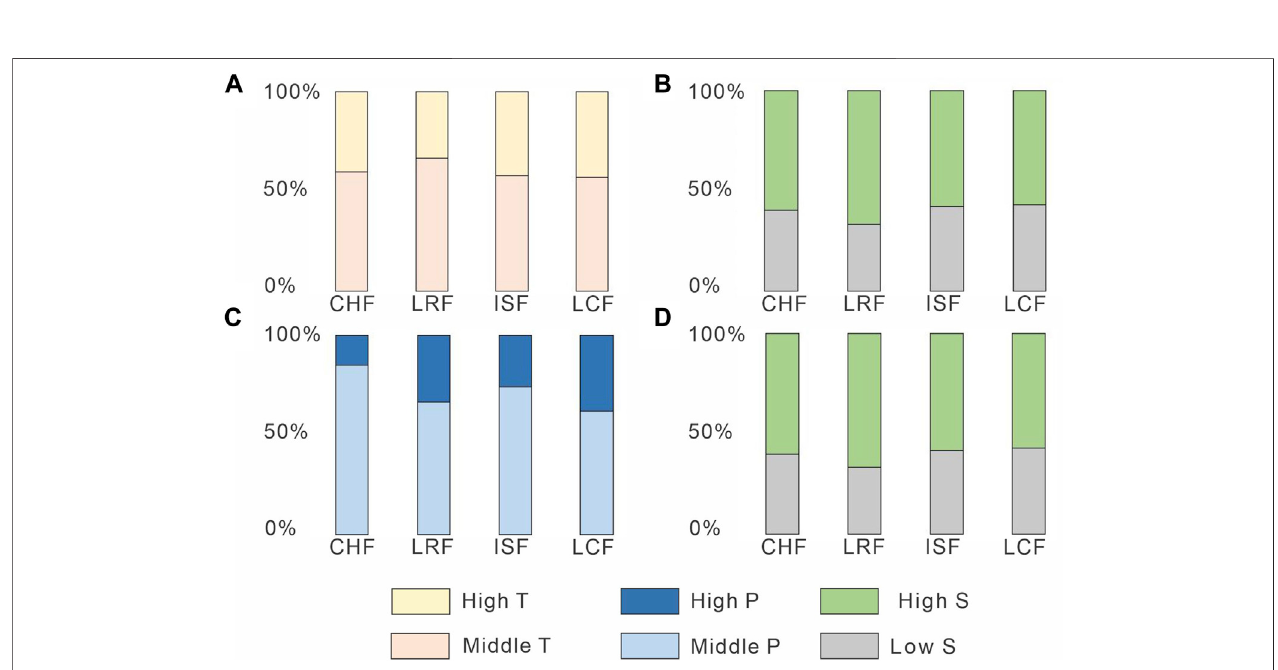
FIGURE 7 | Inferred tetrapod habit preference (based on previous authors) for the Upper Triassic Agua de la Peña Group. (A) . Percentage of prefered range temperature tetrapod taxa. (B) . Percentage of tolerance to seasonal variation in temperature. (C) . Percentage of prefered range precipitation tetrapod taxa. (D) . Percentageoftolerancetoseasonalvariationinprecipitation.CHF,ChañaresFormation;ISF,IschigualastoForamtion;LCF,LosColoradosFormation;LRF,LosRastros Formation.